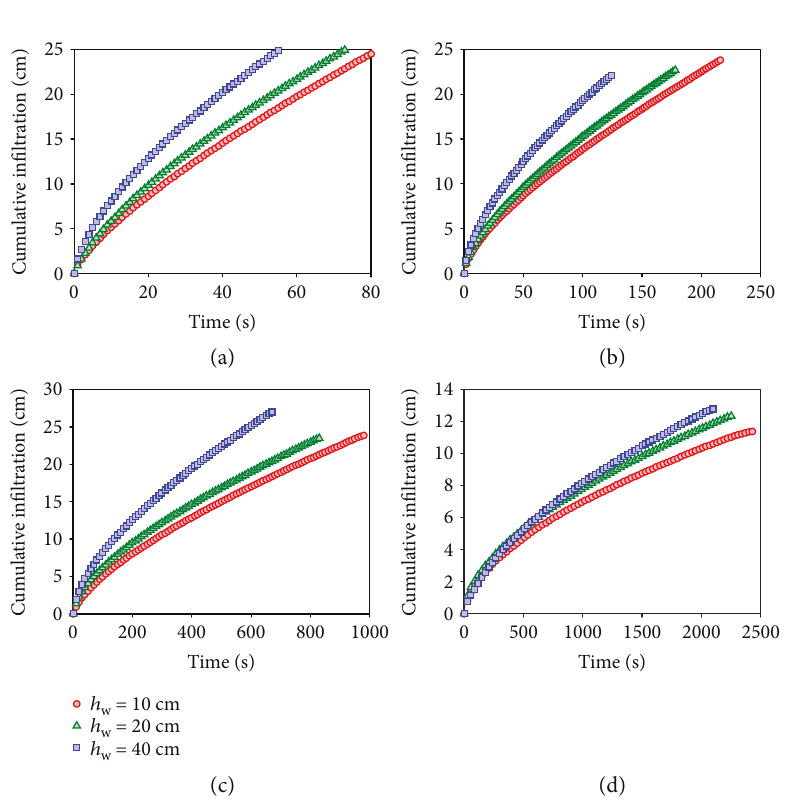
Figure 3: Cumulative in fi ltration versus time of the sands: (a) B35, (b) B60, (c) B150, and (d)